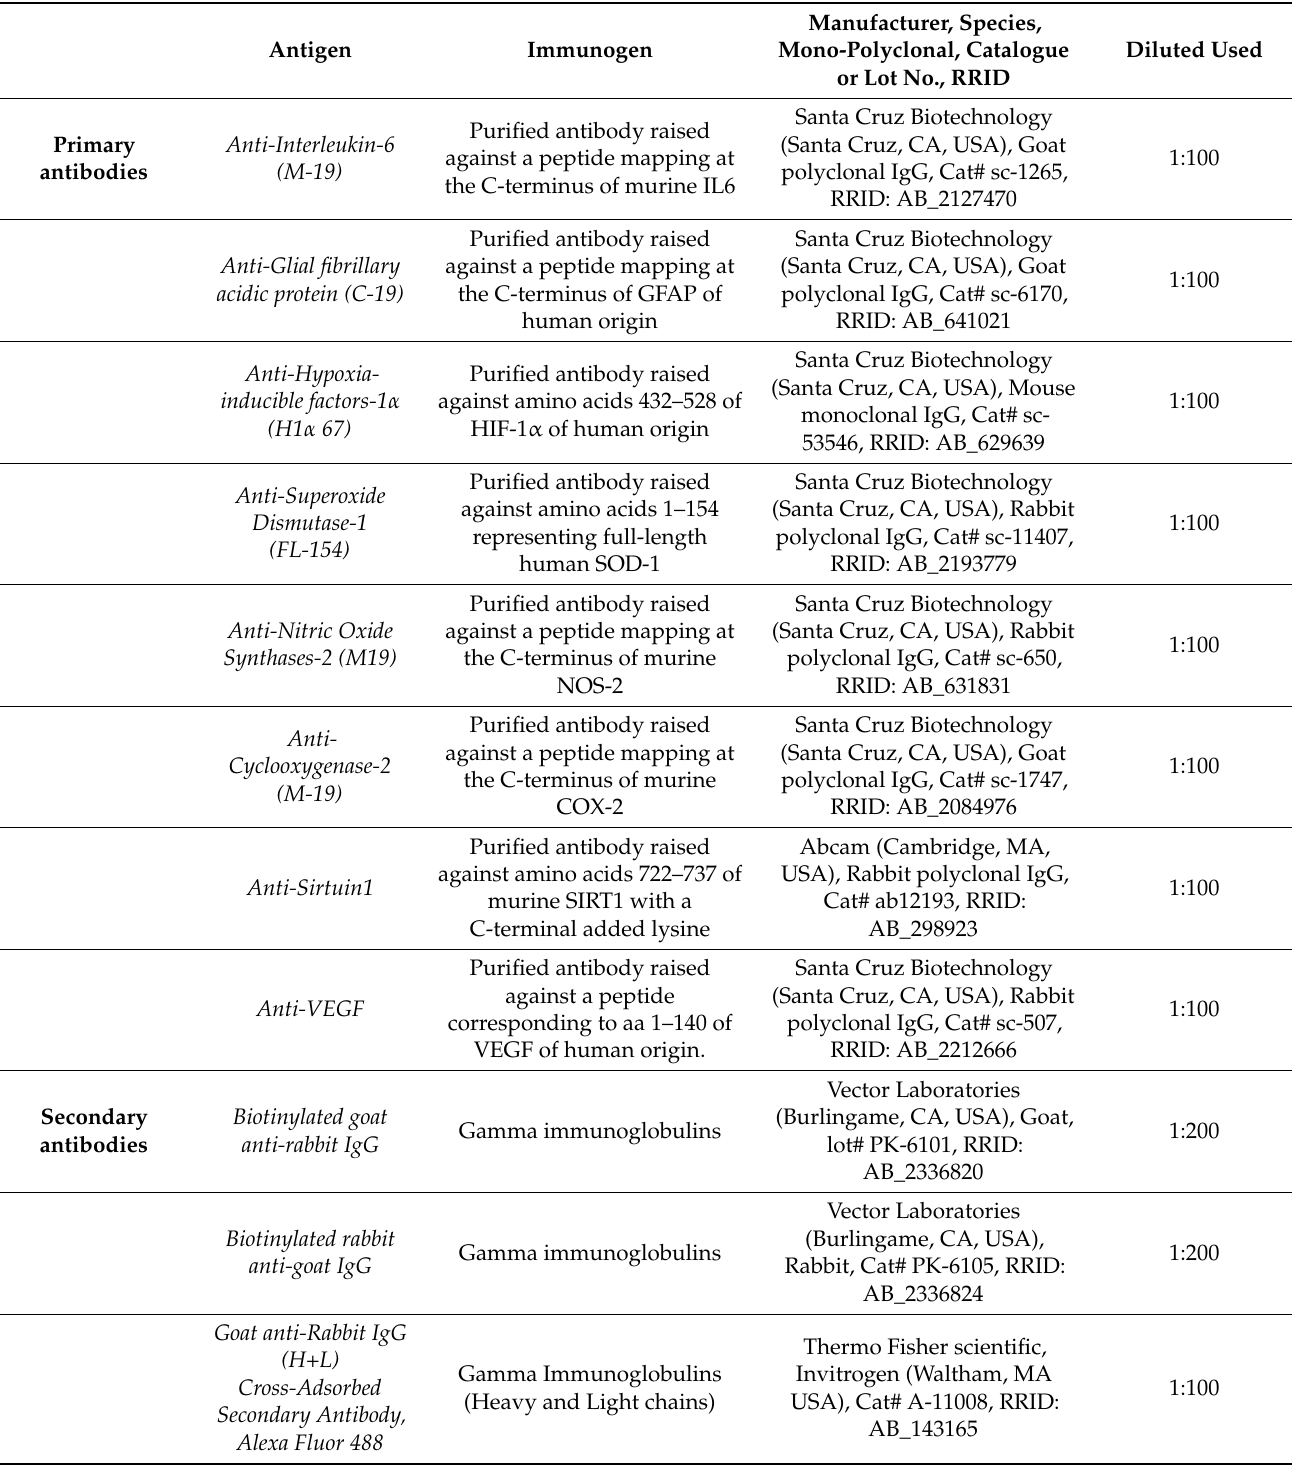
Table 2. Primary/secondary antibodies employed for immunocytochemical/immunofluorescence experimental